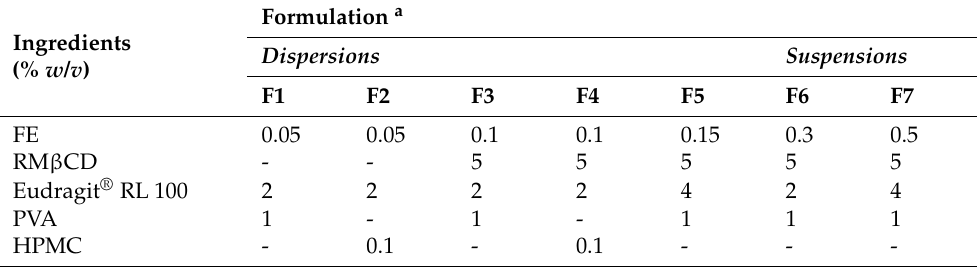
Table 7. The composition of FE-loaded EuNP dispersions and